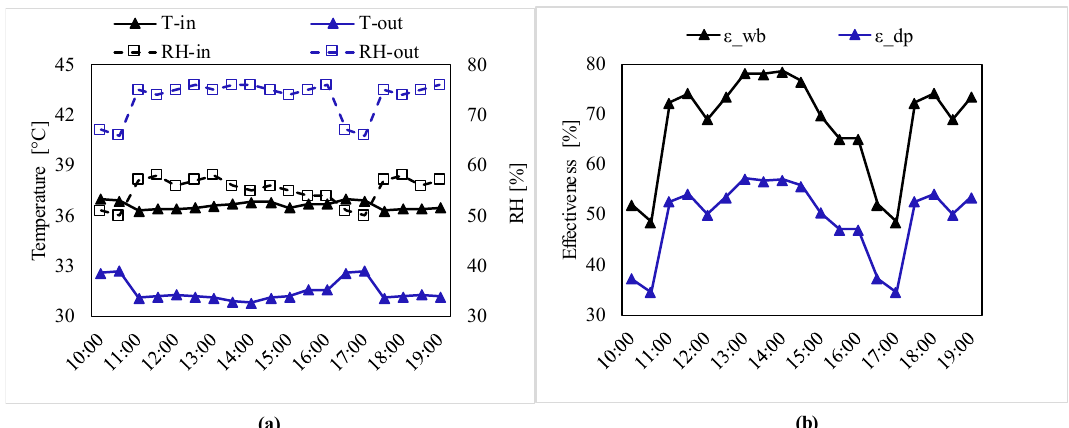
Figure 4. Analysis of experimental MEC system on hourly basis for 15 July for Multan (Pakistan): ( a ) outlet relative humidity and temperature; and ( b ) e ff